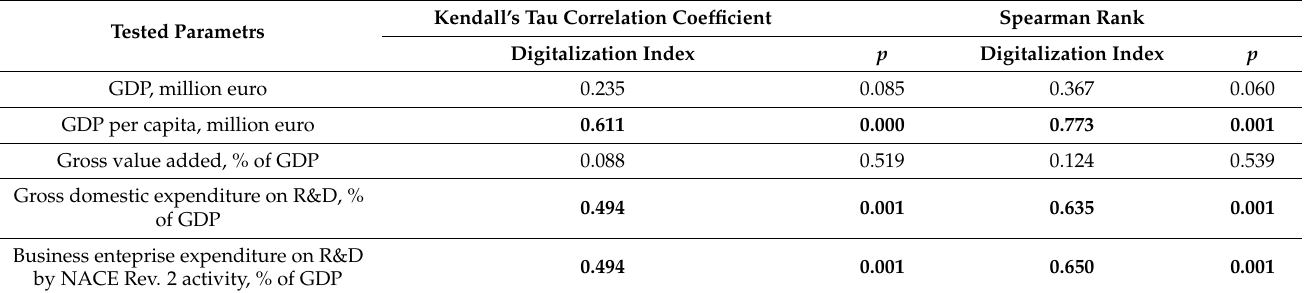
Table 5. The Spearman’s rank correlation coefficient and the Kendall’s Tau Correlation Coefficient be- tween the value of the digitalization index and the basic economic parameters of the EU-27 economy. Kendall’s Tau Correlation Tested Parametrs